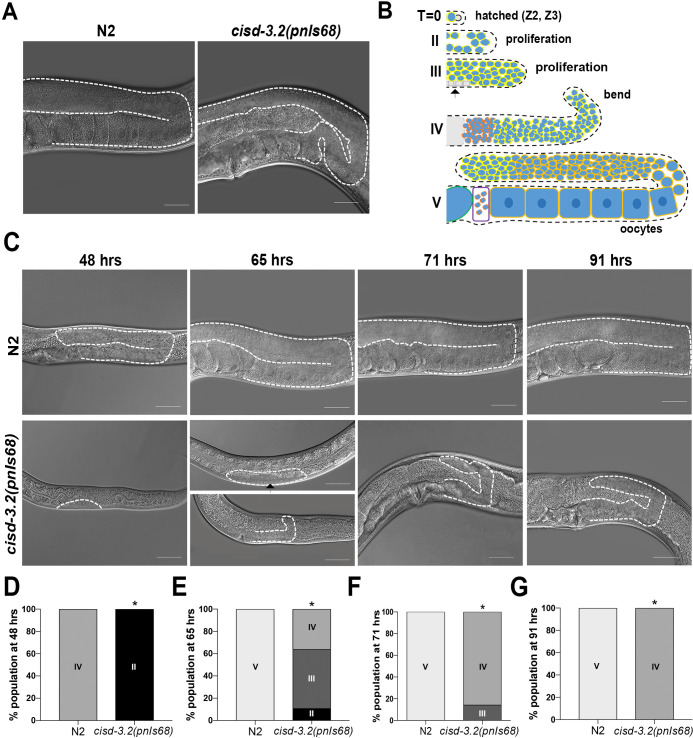
The cisd-3.2(pnIs68) allele leads to an abnormal germline structure and development phenotype.(A) Representative germline images of N2 wild-type and cisd-3.2(pnIs68) gravid adult hermaphrodite. For each animal, the gonad is outlined with a dashed white line. Scale bar indicates 20 μm. (B) Schematic diagram of a single gonad arm to note how the germline was categorized to assess gonad developmental progression. Time zero is at hatching when the germline contains Z2 and Z3 cells. At specific times post hatching, germlines were examined and categorized for initial germ cell proliferation (Class II), moderate germ cell proliferation and the presence of precursor vulva cells (black arrow) (Class III), the formation of a bend within the gonad (Class IV), or the presence of oocytes (Class V). (C) Representative image of the germline within the N2 wild-type or cisd-3.2(pnIs68) hermaphrodite at specified time points. The gonad is outlined with a dashed white line. Black arrow indicates the presence of precursor vulva cells. (D-G) The germline of N2 wild-type and cisd-3.2(pnIs68) hermaphrodite, at specified time points, was examined and classified. At each time point, the percentage of the population for the specified stage of development was determined. Shown is the mean from three independent experiments (n = 30). The * indicates significant difference; P value <0.0001, (Fisher’s exact two-sided test).